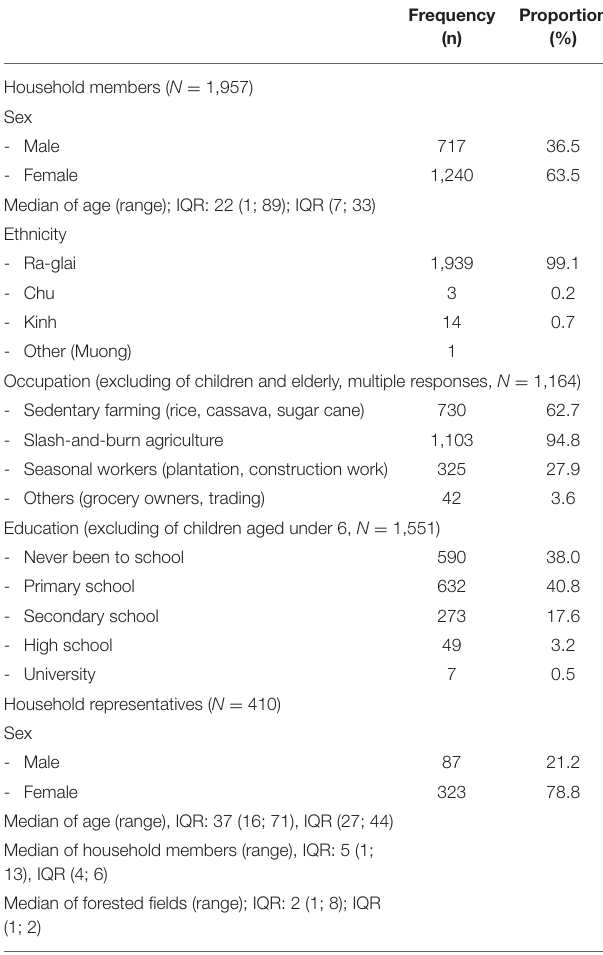
TABLE 1 | Characteristics of survey